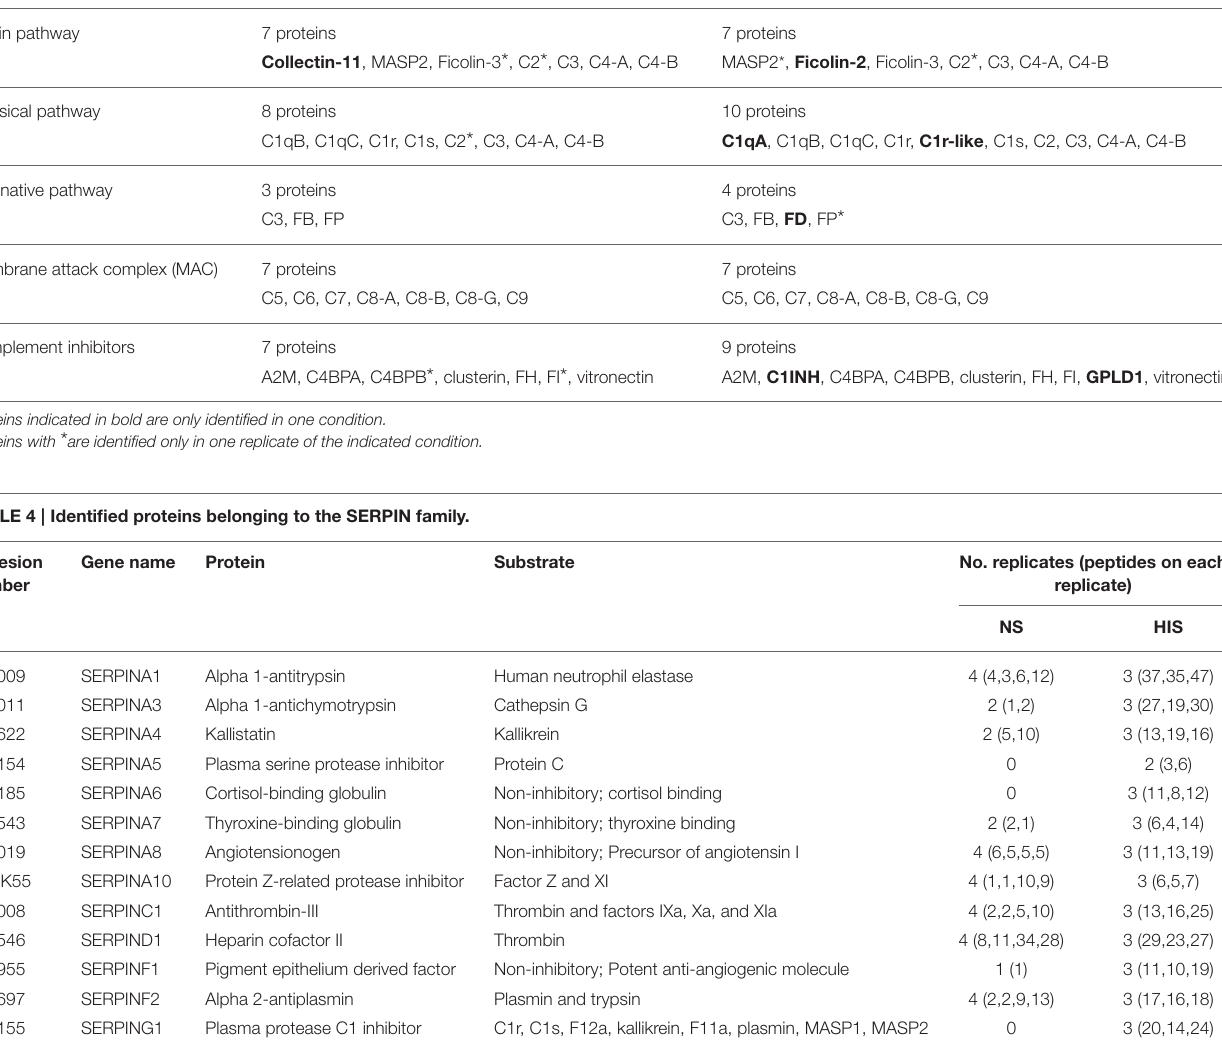
TABLE 3 | Comparison of complement proteins identified on the cell surface of C. albicans by shaving after incubation with NS vs. HIS. Complement proteins